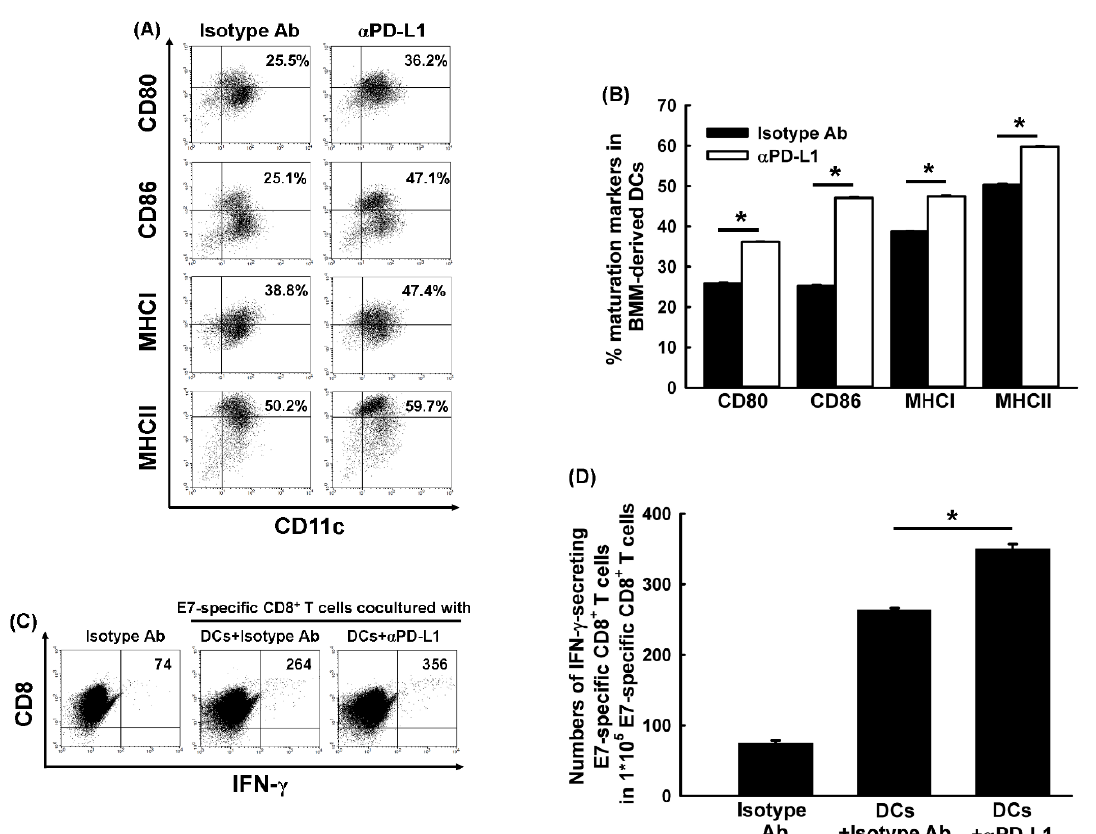
Figure 6. Flow cytometric analysis of the effect of PD-L1 blockade on the expression of various surface markers of BMM-derived DCs and the activation of antigen-specific CD8 + cytotoxic T cells mediated by BMM-derived DCs. ( A ) Representative percentages of BMM-derived CD80 + CD11c + , CD86 + CD11c + , MHC I + CD11c + , and MHC II + CD11c + DCs treated with or without anti-PD-L1 Ab. ( B ) The expression of various surface markers on BMM-derived CD11c + DCs treated with or without anti-PD-L1 Ab. Mice treated with anti-PD-L1 Ab had significantly higher percentages of mature CD11c + DCs than mice treated with the isotype Ab (*: p < 0.001, Student’s t -test). ( C ) Representative figures depicting IFN- γ secretion by E7-specific CD8 + cytotoxic T-cell line co-cultured with E7 peptide-pulsed BMM-derived DCs treated with or without anti-PD-L1 Ab. ( D ) Bar figures depict the number of E7-specific IFN- γ -secreting CD8 + cytotoxic T cells in various treatment groups. The number of E7-specific IFN- γ -secreting CD8 + T cells was highest in BMM-derived DCs from mice pretreated with anti-PD-L1 Ab (*: p < 0.001, Student’s t -test). All experiments were performed independently in duplicate (mean ± SEM).